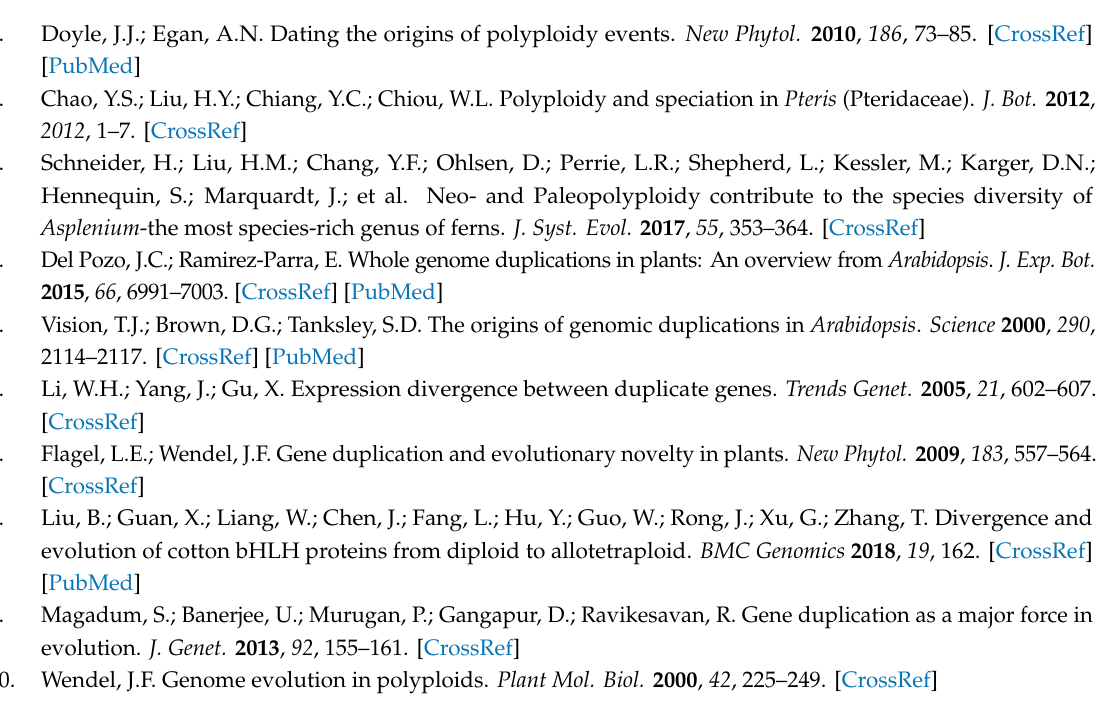
Supplementary Materials: Table S1: Sources of genome data for the non-cotton species analyzed in this study. Table S2: Primers for reverse transcription PCR. Table S3: Primers for quantitative real-time RT-PCR. Table S4: Information regarding the HMGS genes in the non-cotton species analyzed in this study. Table S5: The information of HMGS genes from Gossypium . Figure S1: Phylogenetic tree based on HMGS proteins from G. raimondii , G. arboreum , and 24 other species. The phylogenetic tree was constructed with the NJ method in the MEGA software with default parameters. The bootstrap analysis was conducted with 1000 replicates. Figure S2: Multiple sequence alignment of the predicted GrHMGS2 , GhHMGS2D , GaHMGS2 , and GhHMGS2A coding sequences. Two red boxes represent the location of the “A” base insertion at the 800-bp and the 1085-bp positions in the coding regions of GhHMGS2A and GrHMGS2 , respectively. Three red asterisks indicate the premature stop codon. Figure S3: Alignment of multiple HMGS amino acid sequences from G. raimondii , G. arboreum , and G. hirsutum . The red box represents the conserved motif, “NxD / NE / VEGI / VDx(2)NACF / YxG”, and the active sites are indicated with a red